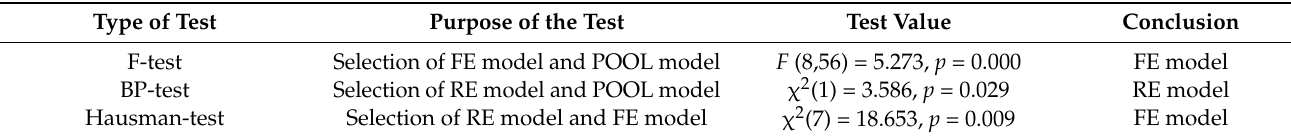
Table 6. Model optimization and selection results.